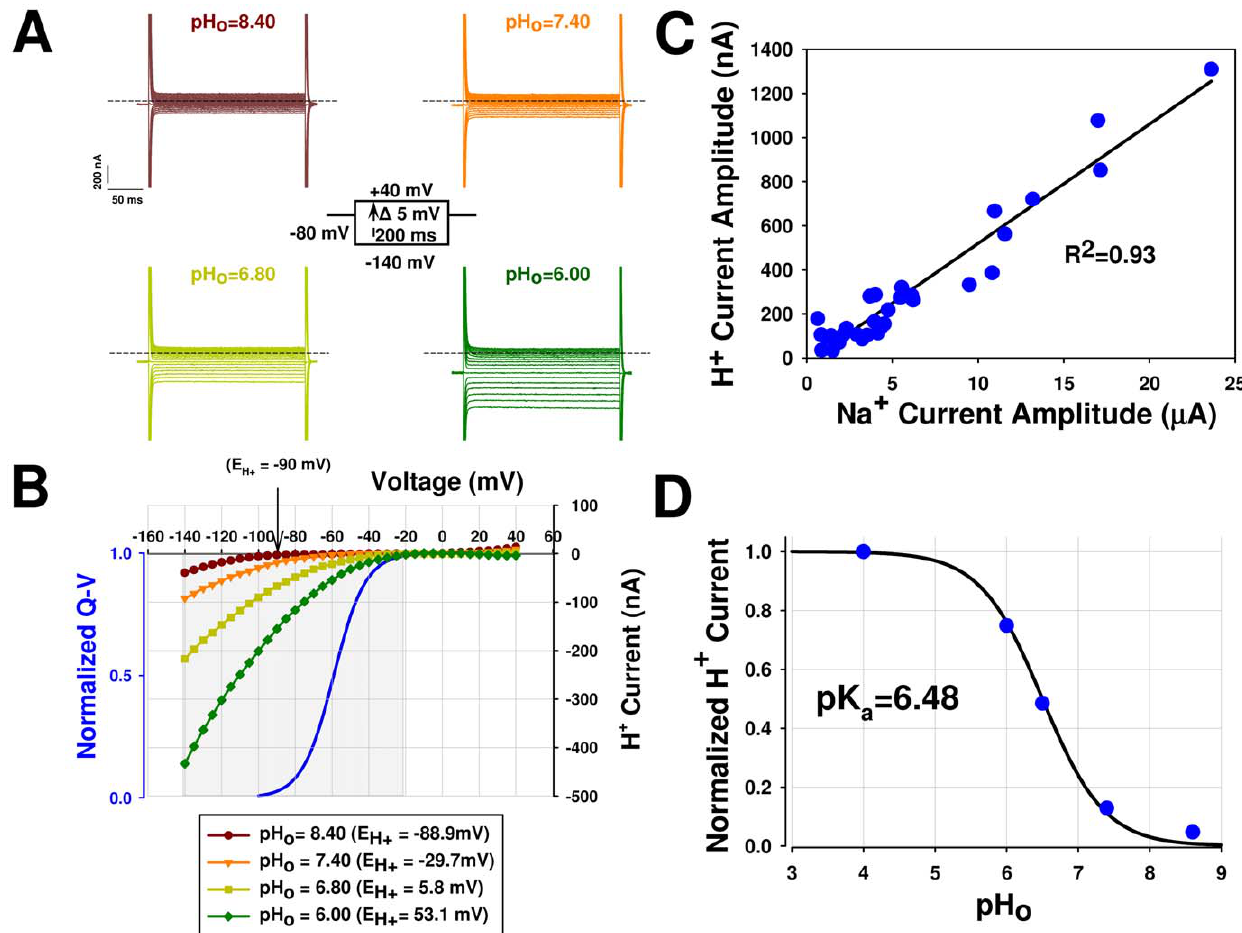
Figure 5. Proton current-voltage relationship of the Na v 1.5/R219H channel recorded in an NMDG Na + -free solution. ( A ) Representative proton current traces from oocytes expressing the Na v 1.5/R219H channel recorded at pH o 8.40, 7.40, 6.80, and 6.00, as indicated, in response to 200 ms voltage steps ranging from 2 140 mV to + 40 mV in 5-mV increments from a holding potential of 2 80 mV (the protocol is given in the centre inset), without on-line leak subtraction. The dashed line represents the zero current. For clarity, only current every 10 mV are shown. ( B ) Current- voltage relationship where the currents in ( A ) were plotted as a function of the test potential (5 mV increments), after offline linear leak subtraction. Reversal potential determined in a Na + -free NMDG solution at pH o 8.40 using voltage steps as described in ( A ). The pH i was measured using a